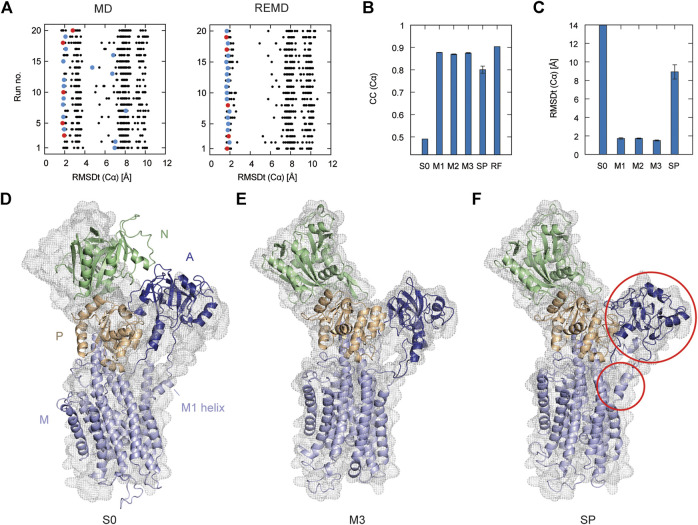
Flexible fitting of Ca2+-ATPase from E2 to E1∙2Ca2+ state. (A) RMSDt of Cα atoms of best CC models of each of 32 MD replicas at different force constants for 20 independent simulation runs. The best CC replica in each run is colored and the chosen 5 best models are highlighted in red. MD and REMD panels show simulations without and with exchanges between replicas, respectively. (B) Average CC of the initial structure (S0) and 5 best models in the multi-scale protocol stages: CG REMD simulations (M1), targeted MD (M2), AA MD (M3) and in the simple protocol (SP). Standard deviation is shown as an error bar. (C) RMSDt of the (Cα) atoms of the same structures. (D) Initial structure used for simulations, superimposed on the target density map. (E, F) The highest CC model obtained using the multi-scale protocol and simple protocol, respectively.